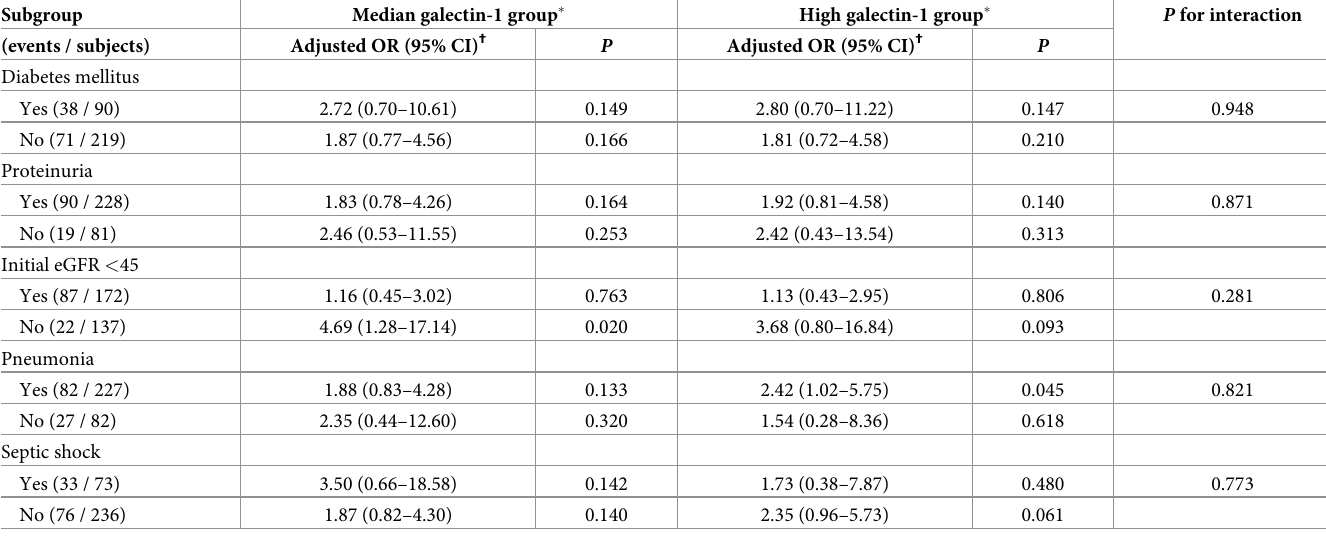
Table 6. Stratified risk of acute kidney injury in patients grouped by the presence of diabetes, proteinuria, renal insufficiency, pneumonia, and septic shock.